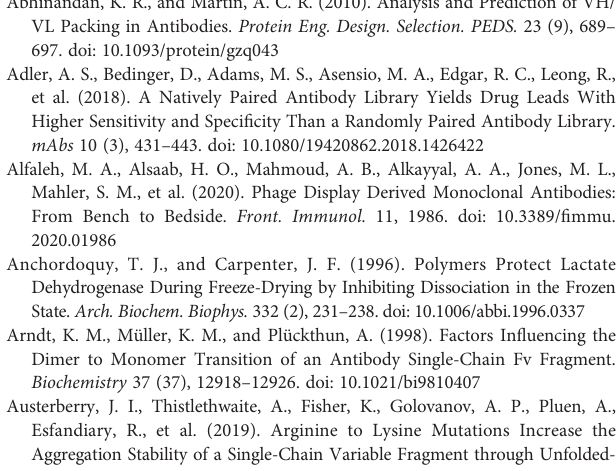
Supplementary Table 1 | Summary of EC 50 values and percentages of monomers after lyophilization of TUN219-2C1-hFc in MTPs using